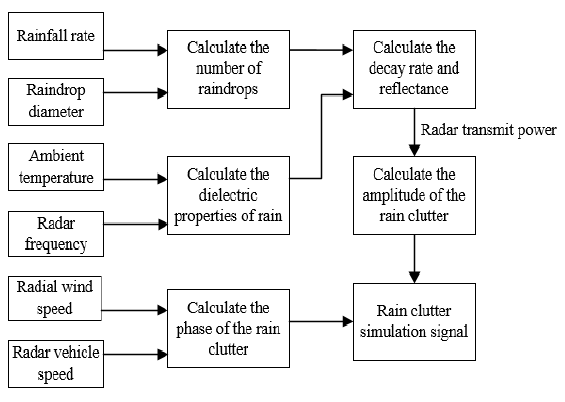
Figure 14. Rain clutter modeling method.